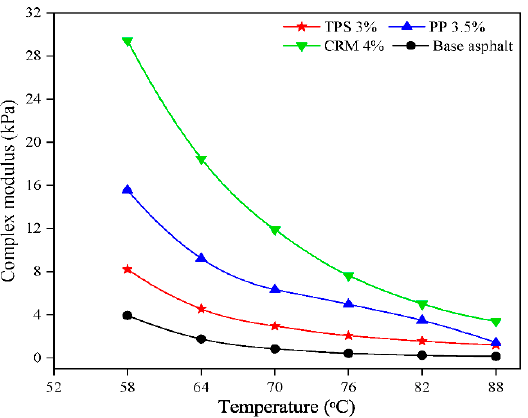
Figure 6. G*/sin( δ ); temperature curves of modified and unmodified asphalt binders.